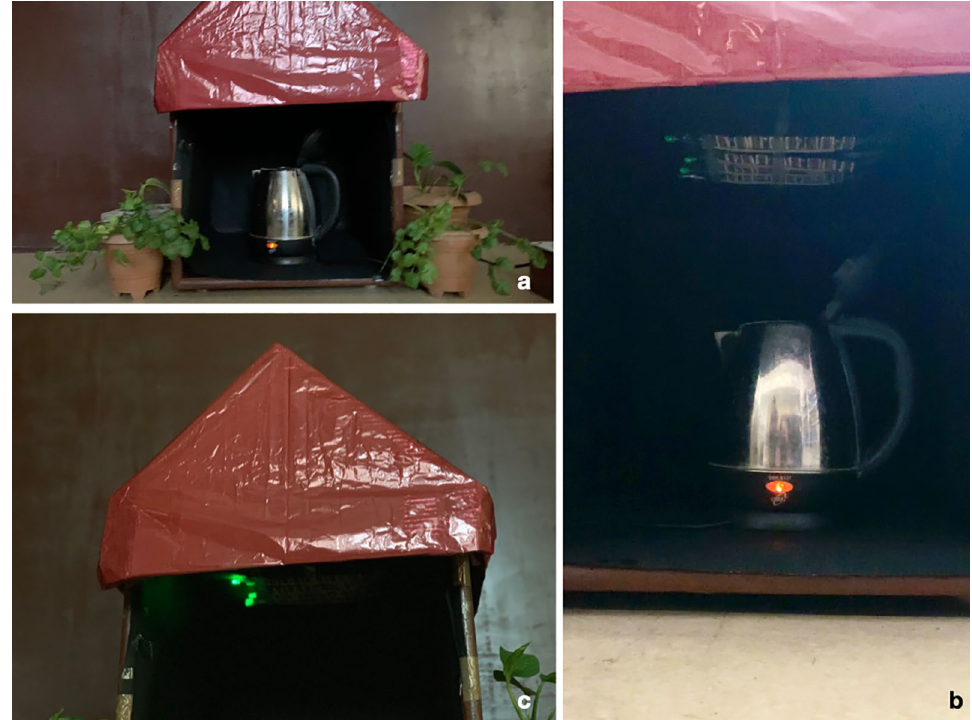
Figure 8. The water–vapor panels for futuristic homes. ( a ) The set-up shows the prototype of a model home with the panels made up of ’brine-silk cocoon protein bio-battery.’ ( b ) The panels receive water vapor from the bottom. The glowing devices as seen on the roof. ( c ) The brightly glowing devices on the roof of the model